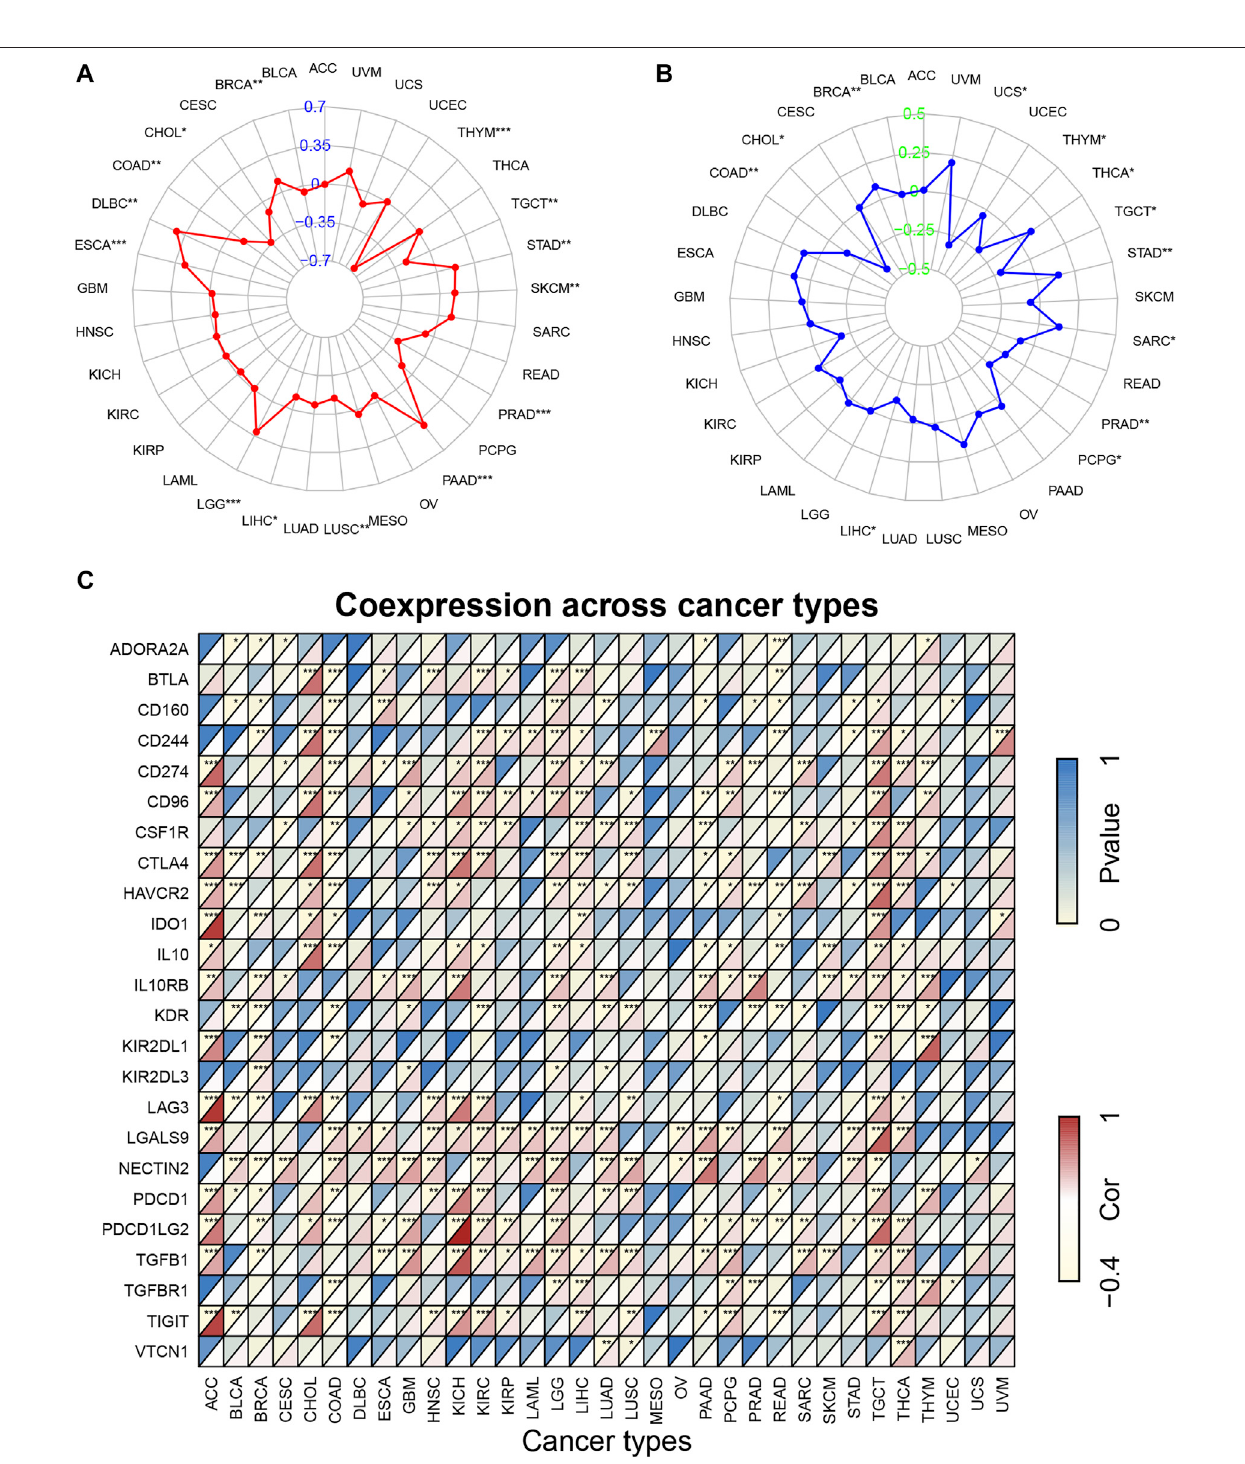
FIGURE 7 | Correlation of KCNN4 expression with TMB, MSI, and ICGs. (A) Correlation between KCNN4 expression and TMB. (B) Correlation between KCNN4 expression and MSI. (C) Correlation of KCNN4 expression and ICGs.